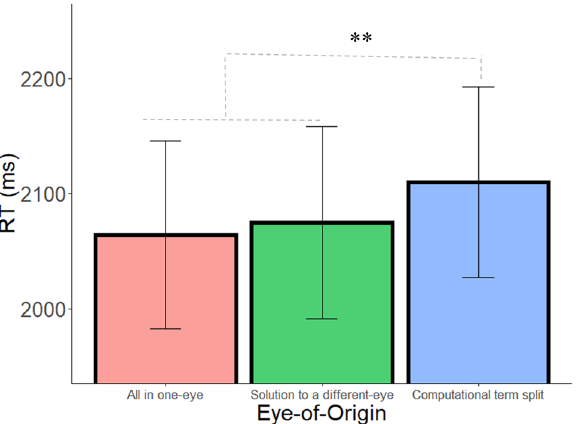
Figure 4. RT as a function of eye-of-origin when equations were vertically aligned. Error bars = SEM. ** = p <